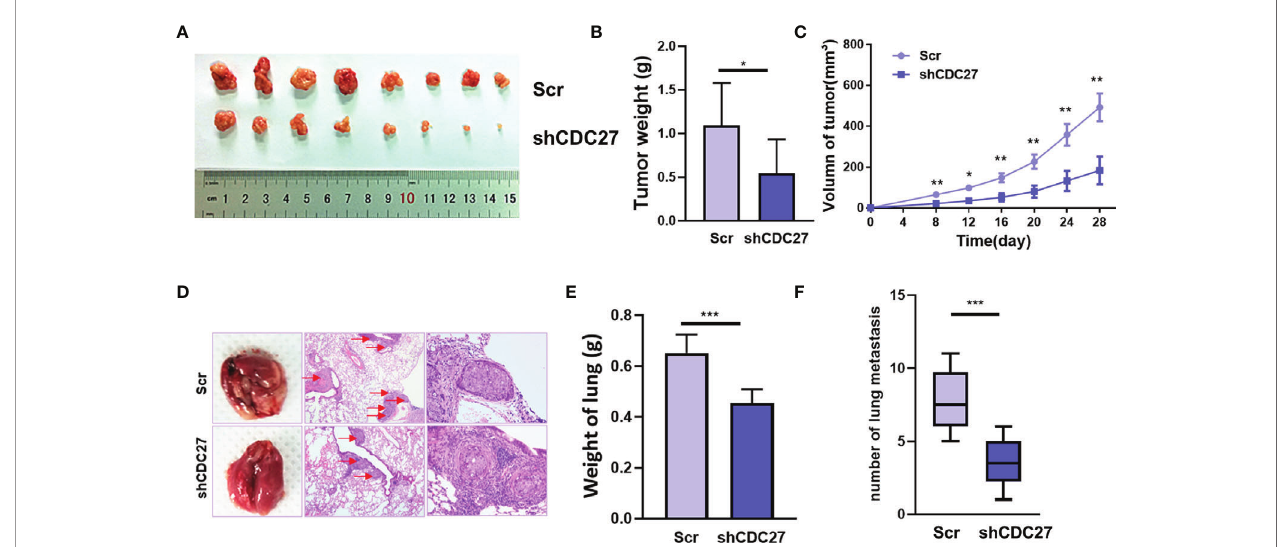
FIGURE 4 | CDC27 promoted the proliferation and metastasis of NB cells in vivo . (A) Xenograft tumors were collected 28 days after cell injection. (B, C) The weights of the tumors were analyzed, and data points are presented as the means ± SD for tumor volumes. (D) Representative images of metastatic lung nodules of HE-stained sections are shown, and the metastatic nodules are highlighted by red arrows. (E, F) The weight of the lungs and the number of lung metastatic nodules were analyzed. ***p < 0.001, **p < 0.01, *p < 0.05 based on Student ’ s t